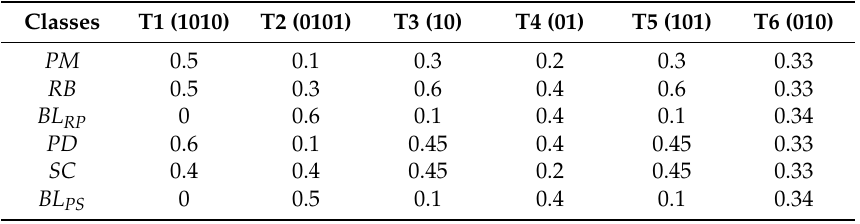
Table 2. Type of Andrews’ curve dynamic and possibilities 1